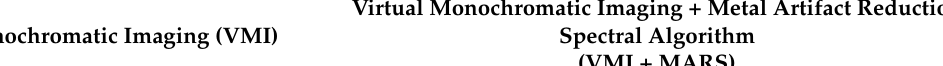
Table 3. Suggested combination of VMI and MARS to minimize metal artifacts for implant ‐ spe ‐ cific CT imaging. The check mark ✓ indicates the conditions that generated the lowest number of total artifatcs.